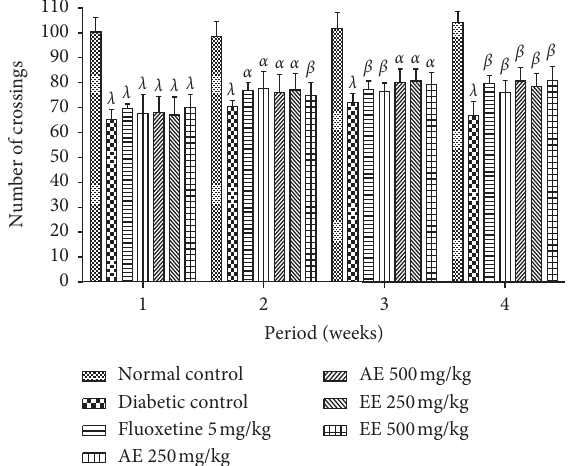
Figure 13: Effects of the aqueous (AE) and ethanol (EE) extracts of Dissotis thollonii on the locomotor activity of mice in the open field test during 5mins. Values are expressed as mean ± SEM for six animals and analyzed by two-way ANOVA followed by Bonferroni post hoc test. α p < 0 . 05, β p < 0 . 01, λ p < 0 . 001 when compared with the normal